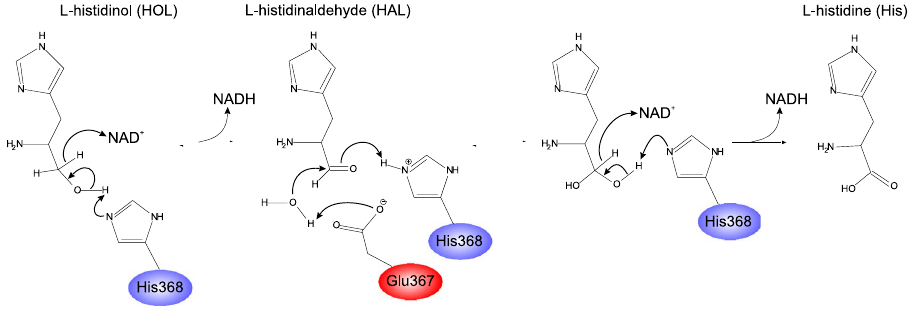
Figure 1. Mechanism of the reaction catalysed by Mt HDH. The figure is modified from 12, 16, 39